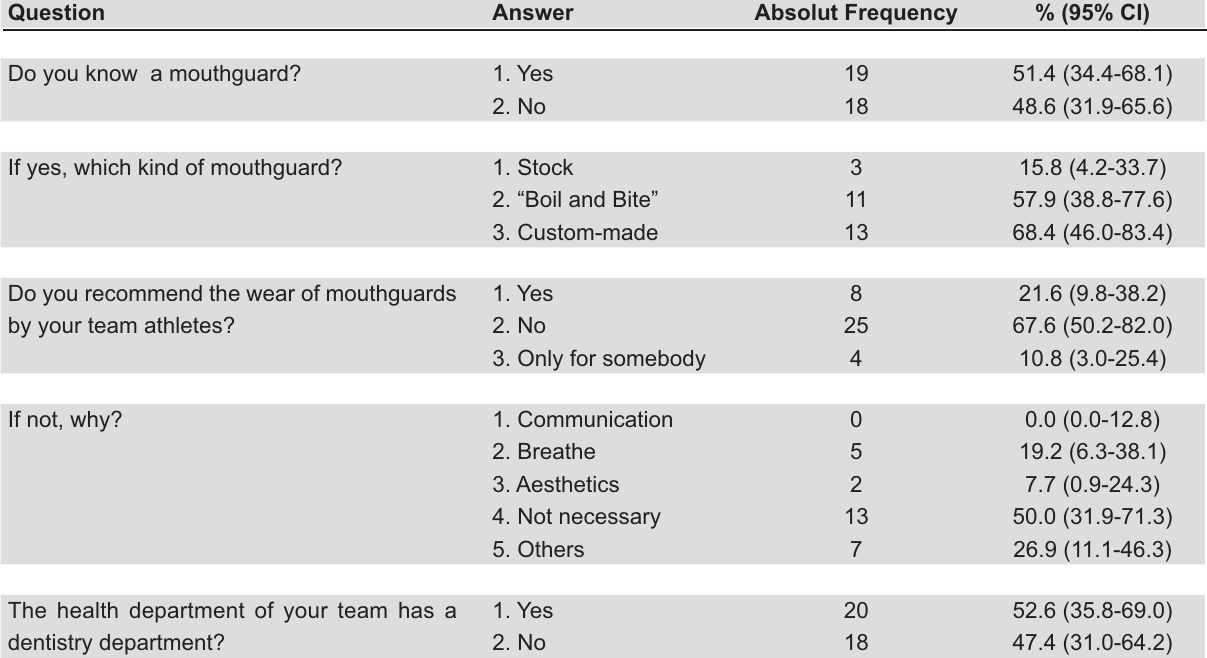
Table 3- Knowledge about mouthguards of health departments’ responsible